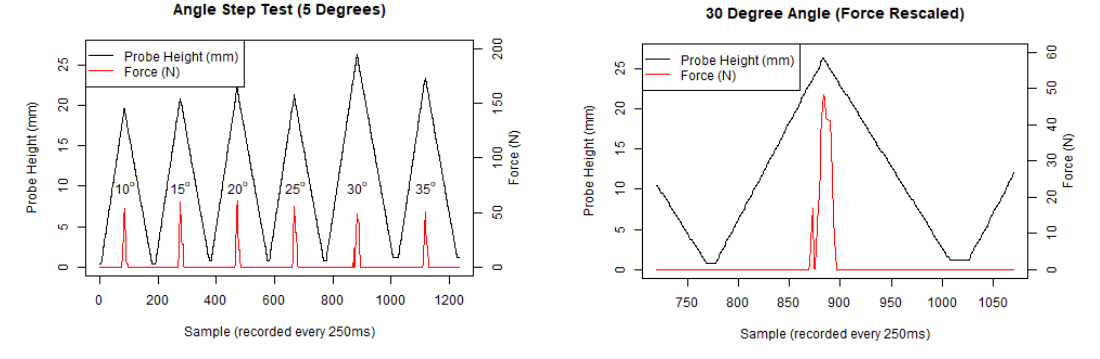
Figure 10. Angled concrete benchmarking